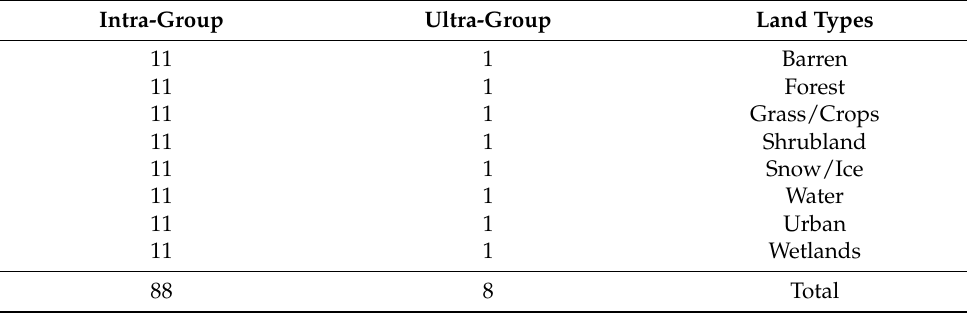
Table 1. Number of Scenes included in the Intra-Group and the